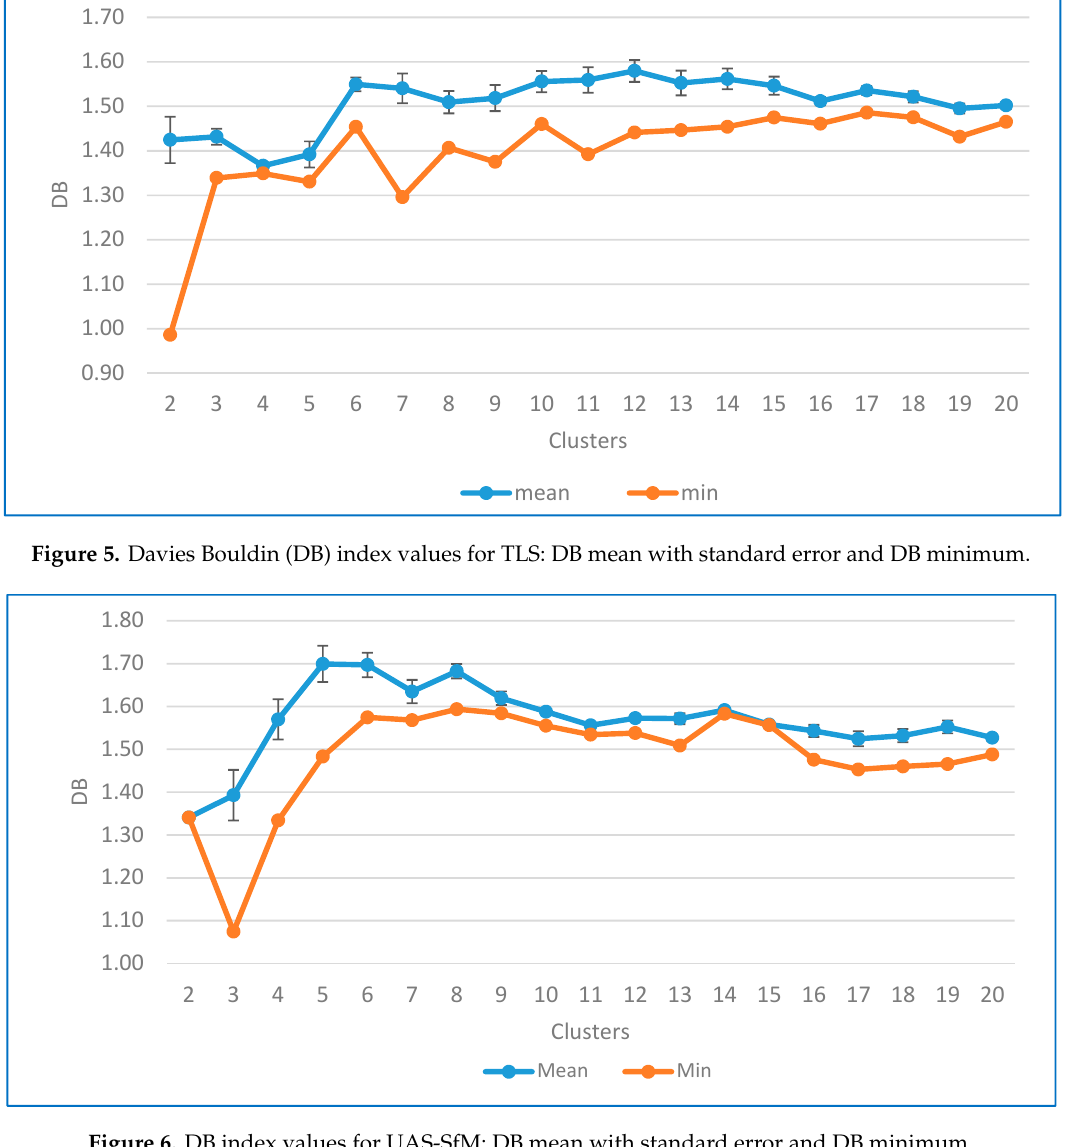
Figure 6. DB index values for UAS-SfM: DB mean with standard error and DB minimum.